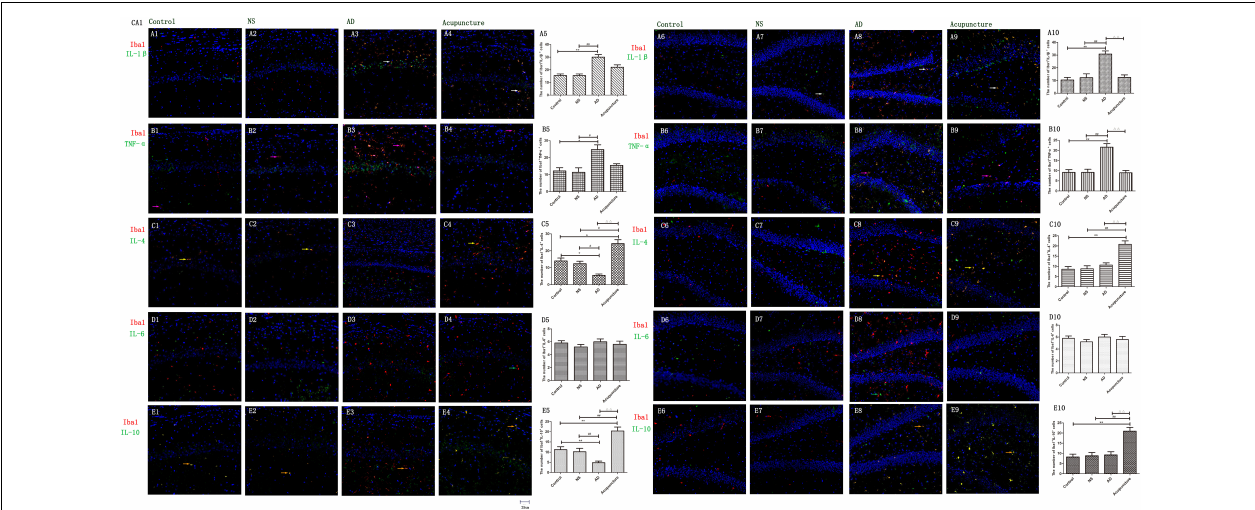
FIGURE 4 | The microglial cytokines in different groups. The microglial cytokines were double-stained with cytokine antibodies and anti-Iba1 antibody. (A1–4) Double staining with IL-1 β and Iba1 (CA1 area). (A6–9) Double staining with IL-1 β and Iba1 (DG area). (B1–4) TNF- α and Iba1 (CA1 area). (B6–9) TNF- α and Iba1 (DG area). (C1–4) IL-4 and Iba1 (CA1 area). (C6–9) IL-4 and Iba1 (DG area). (D1–4) IL-6 and Iba1 (CA1 area). (D6–9) IL-6 and Iba1 (DG area). (E1–4) IL-10 and Iba1 (CA1 area). (E6–9) IL-10 and Iba1 (DG area). (Red expresses Iba1-positive cells, green expresses cytokine-positive cells, and blue expresses DAPI. The white arrow expresses IL-1 β + Iba1 + cells. The pink arrow expresses TNF- α + Iba1 + cells. The yellow arrow expresses IL-4 + Iba1 + cells. The green arrow expresses IL-6 + Iba1 + cells. The beige arrow expresses IL-10 + Iba1 + cells.) (A5,B5,C5,D5,E5,A10,B10,C10,D10,E10) The number of positive double-stained cells in different groups. Error bars: SE. Compared with Control group, * p < 0.05, ** p < 0.01; compared with NS group, # p < 0.05, ## p < 0.01; compared with AD group, (cid:77)(cid:77) p < 0.01 ( n =